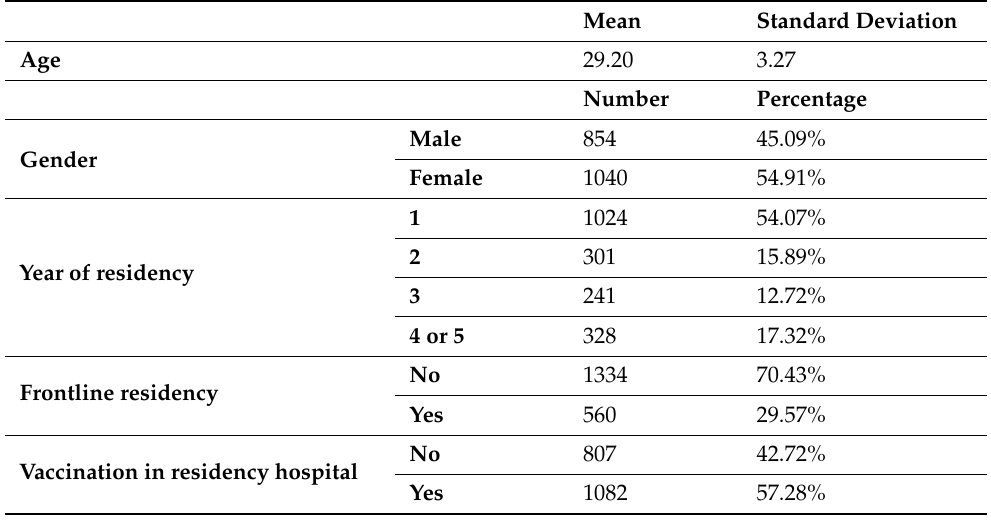
Table 1. Sociodemographic characteristics of the